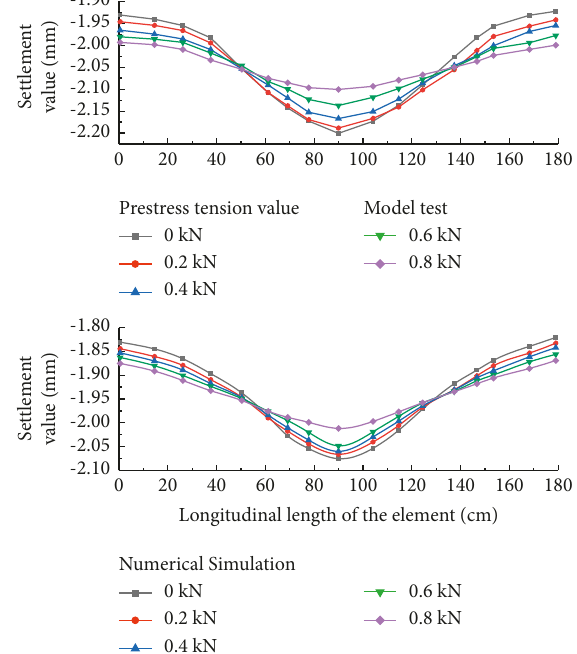
Figure 16: Comparison of measured settlements and finite element analysis settlements.